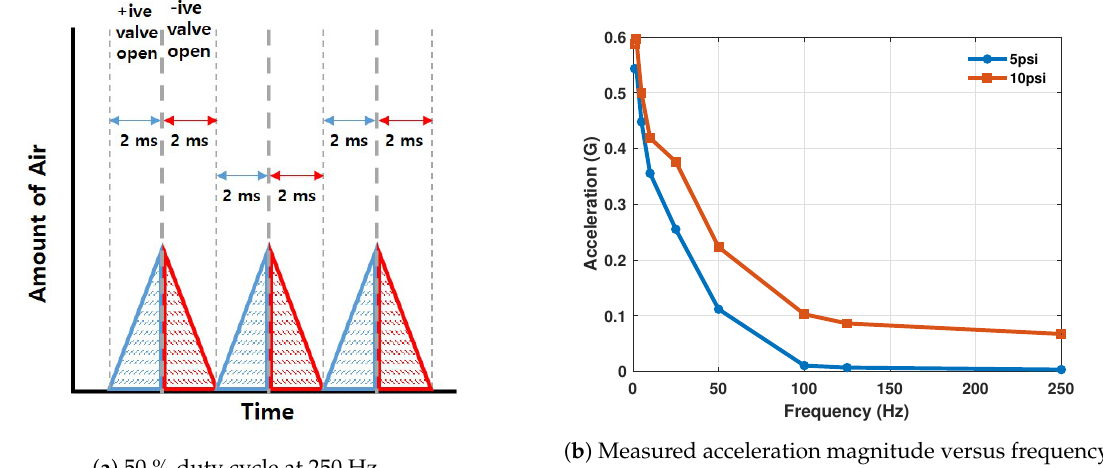
Figure 5. Quantitative analysis of high frequency vibration rendering by the haptic